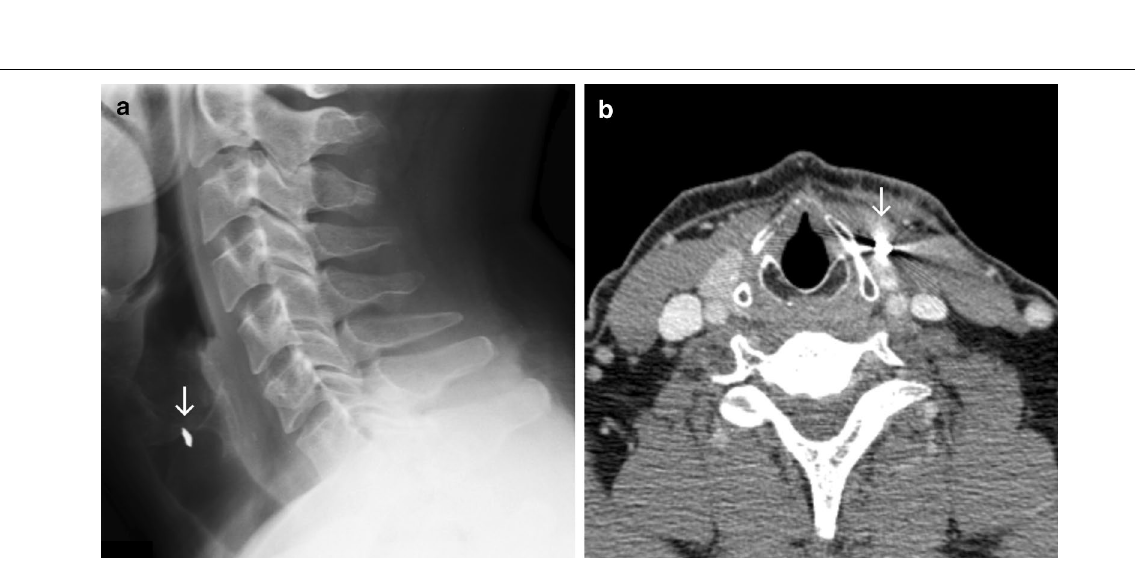
Fig. 7 Broken hammer. Lateral radiograph ( a ) and axial contrast enhanced CT image ( b ) showing a radiopaque/hyperdense structure (arrow) anteromedial to the sternocleidomastoid muscle and lateral to the thyroid cartilage. Streak artefacts in the CT image indicate marked density, a potential clue that the foreign object is